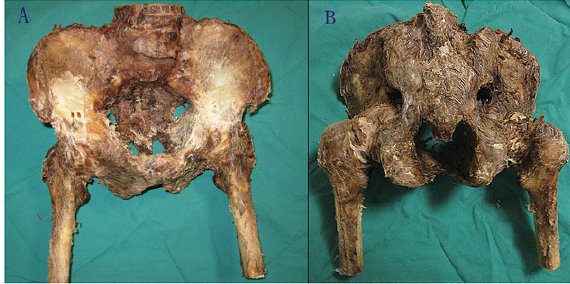
Figure 1 - Normal specimens (A. front, B. back).